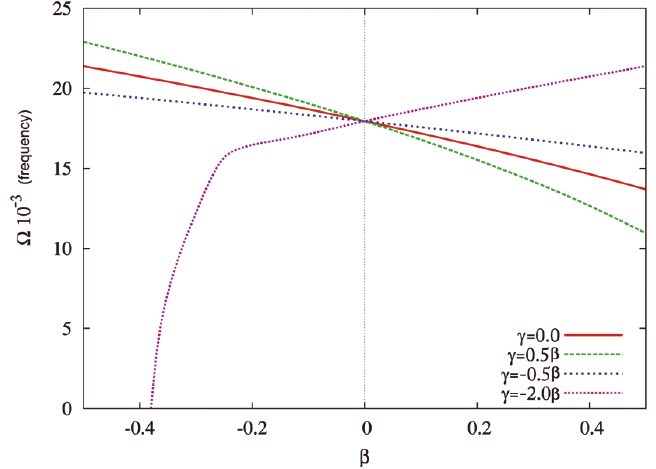
Fig. 12. PLATE-41, LD1, a/h = 30, a = b, SSSS.